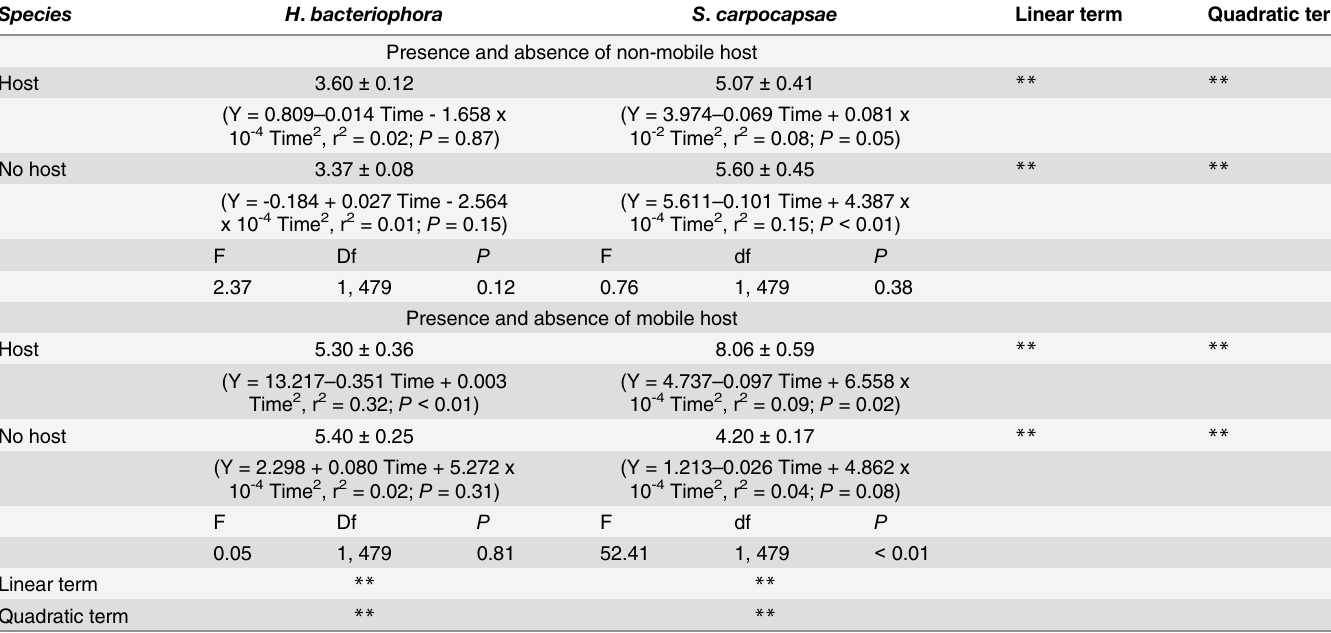
Table 2. Comparison of average population displacement of Heterorhabditis bacteriophora and Steinernema carpocapsae in the presence and absence of mobile and non-mobile hosts.